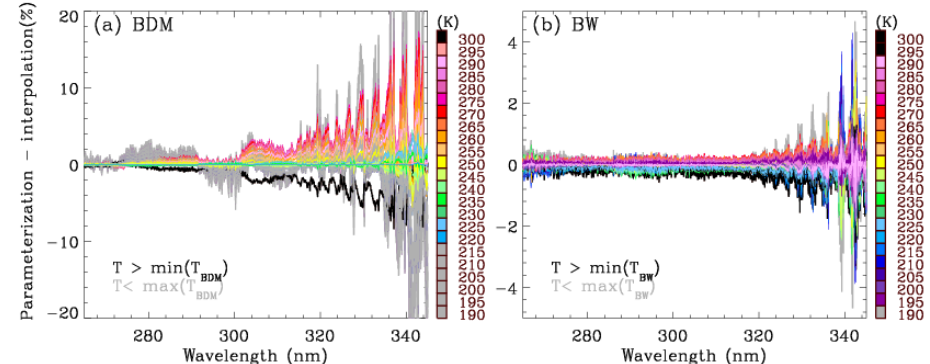
Figure 3. Relative differences of ozone cross-sections parameterized and spline interpolated at temperatures between 190 and 300K for (a) BDM and (b) BW, respectively. In the legend, the temperatures not covered by each dataset are indicated with gray and black for values beyond lower and upper boundaries, respectively; thus, slightly different color scales are used in these two panels for those outside the measured temperature range.